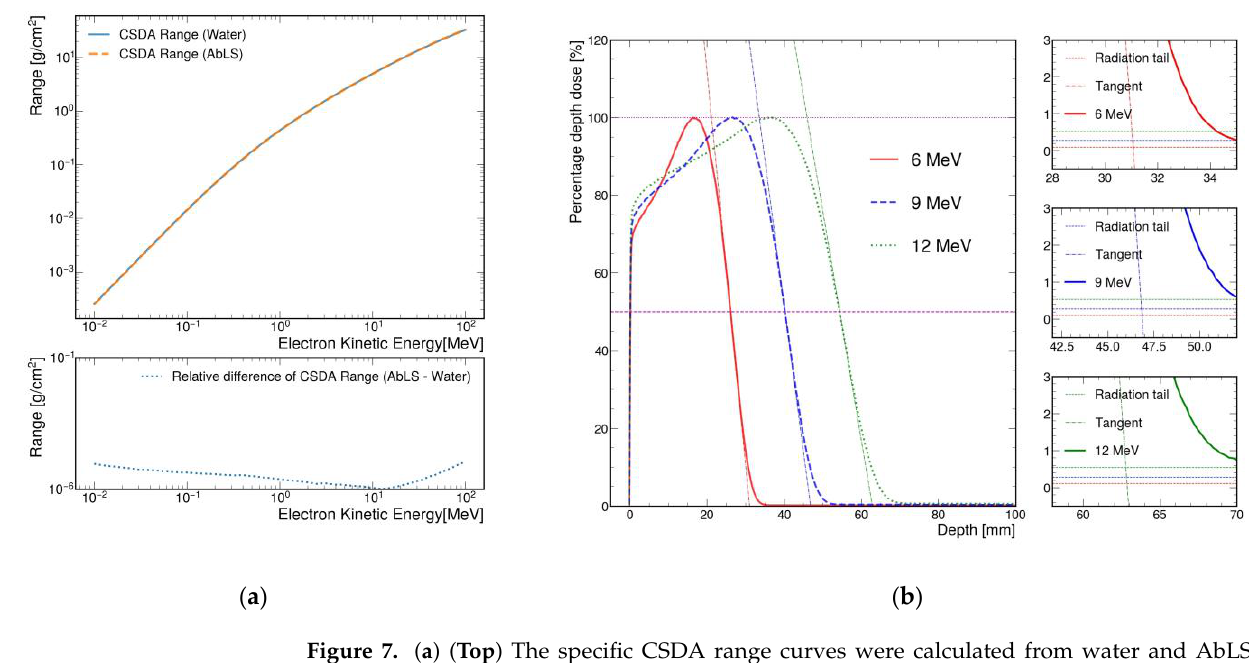
Figure 7. ( a ) ( Top ) The specific CSDA range curves were calculated from water and AbLS for 10 − 2 –10 2 MeV electron beams. The specific CSDA ranges of AbLS for 6, 9, and 12 MeV electron beams were 3.04, 4.50, and 5.89 g/cm 2 . When divided by the density (0.945 g/cm 3 ) of AbLS, the CSDA ranges of AbLS were 3.22, 4.76, and 6.23 cm. ( Bottom ) The calculated specific CSDA ranges for AbLS and water were almost the same. ( b ) The projected ranges with MC simulations were 3.11, 4.68, and 6.28 cm. The projected ranges measured with the fluorescent image were 3.17 ± 0.30, 4.75 ± 0.30, and 6.41 ± 0.60 cm. The three insets on the right side were enlarged regions near the intersection of background and the extrapolated linear line for accurate practical range measurement.